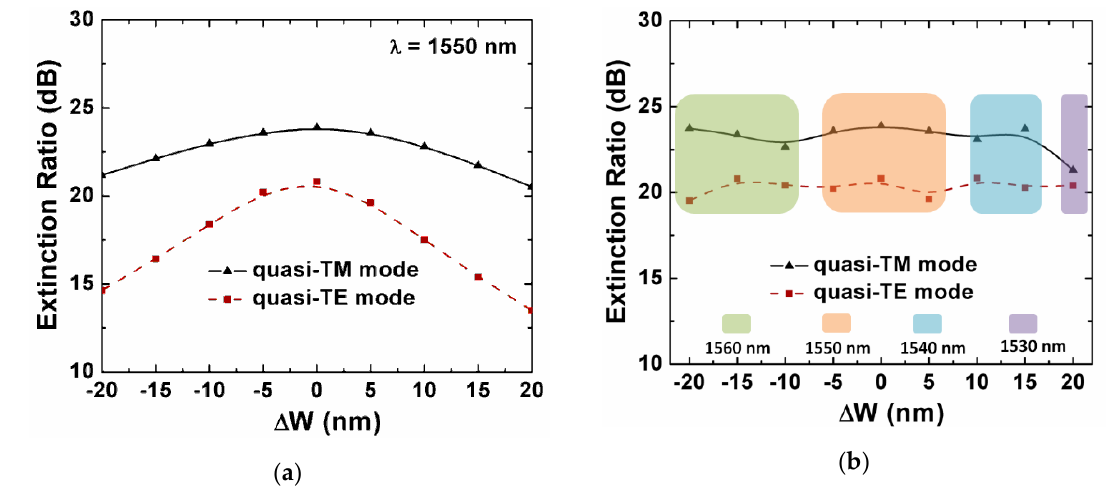
Figure 9. ( a ) Extinction ratio at 1550 nm of the quasi-TM and quasi-TE mode as a function of the waveguide width deviation Δ w ; and ( b ) the maximum extinction ratio in the wavelength range of 1500–1600 nm of the quasi-TM and quasi-TE mode as a function of the waveguide width deviation Δ w .